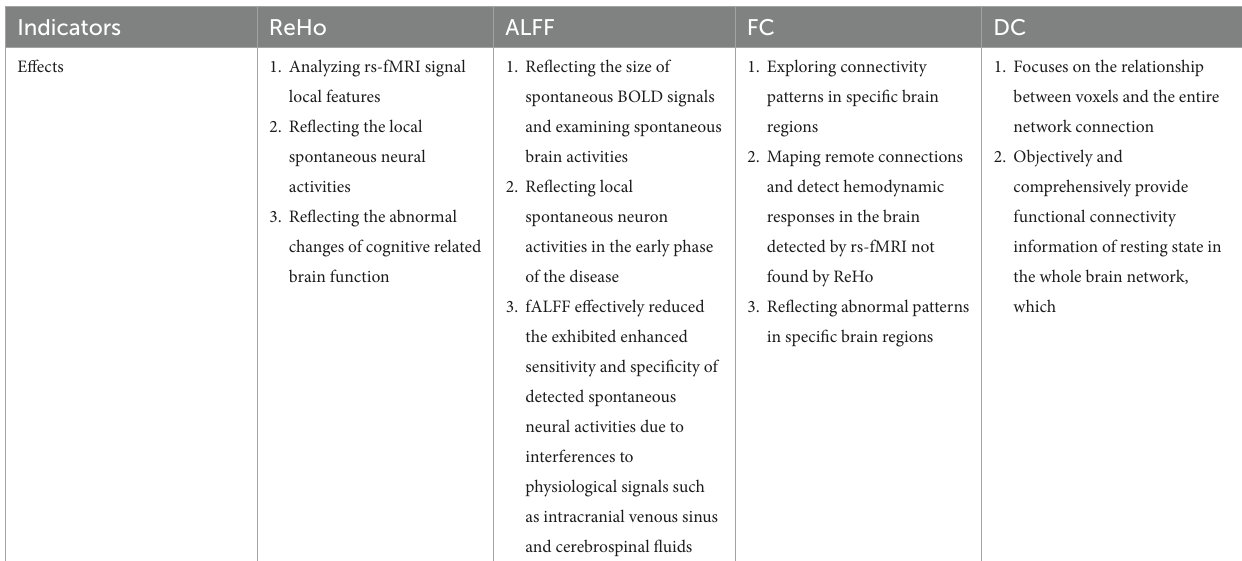
TABLE 1 The common clinical indicators of rs-fMRI in